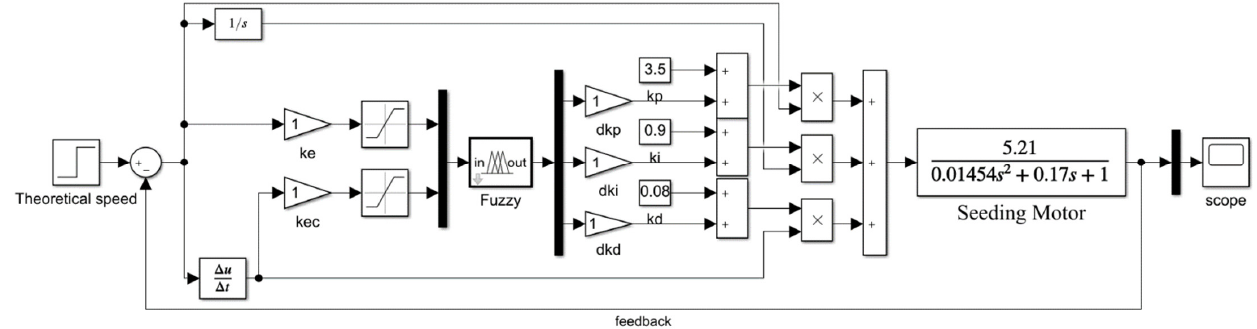
Figure 3. Simulink model of fuzzy PID control system with quantitation-scaling coefficients.